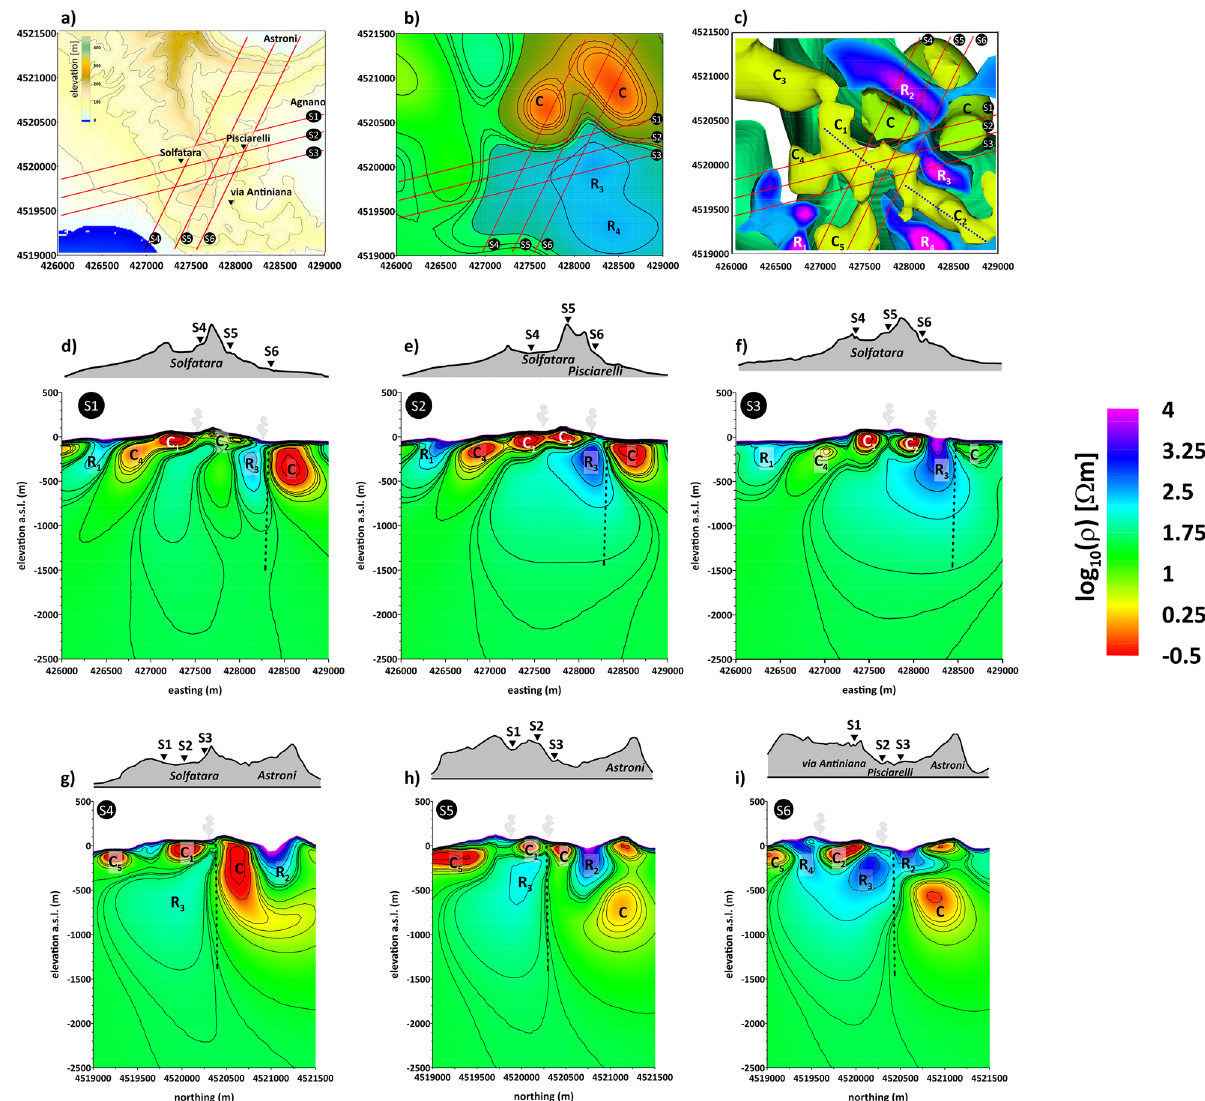
Figure 2. ( a ) Map of the area investigated through the MT surveying ( b ) plane map of the electrical resistivity at 700 m depth b.s.l. ( c ) isosurface representation of the 3D resistivity model in top view. The red lines in the last three panels indicate the directions of the S1–S6 profiles discussed in the text. ( d–i ): Resistivity cross-sections extracted by the 3D model along the S1–S6 profiles. The elevations along the profiles are reported along the top of the images. The main electrical features are labelled with capital letters. The black dotted lines indicate the transition between the S-PHS and the A-AHS (see text). The same common logarithmic scale represents the electrical resistivity in all the